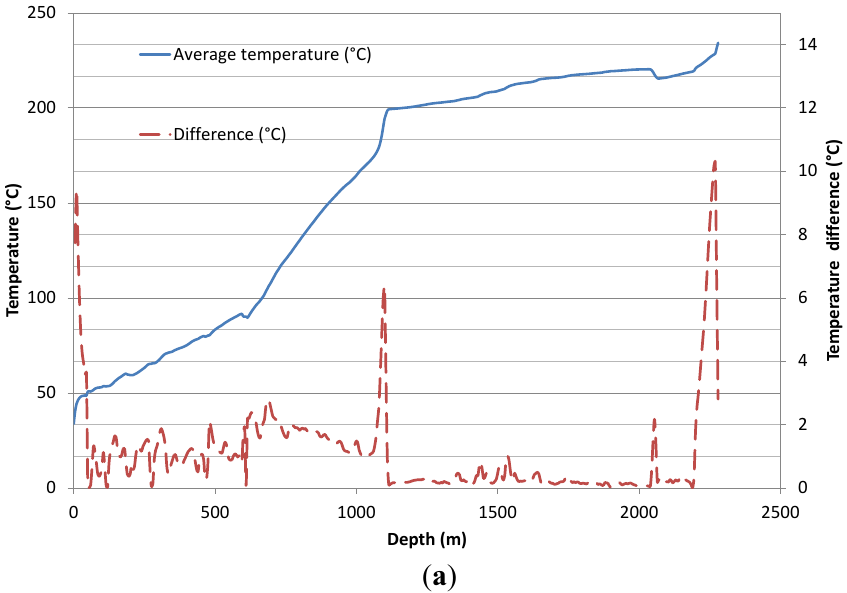
Figure 2. ( a ) Average temperature data for MON-1; ( b ) Average temperature data for MON-2. Average temperature for up and down runs from wireline temperature logs. The temperatures have been averaged over each 5 m interval and the averages for the upward and downward going sections of the survey have been averaged. The difference between the estimates obtained between the upward and downward sections of the survey are also shown. A linear fit across the perturbed region in well MON-2 is also